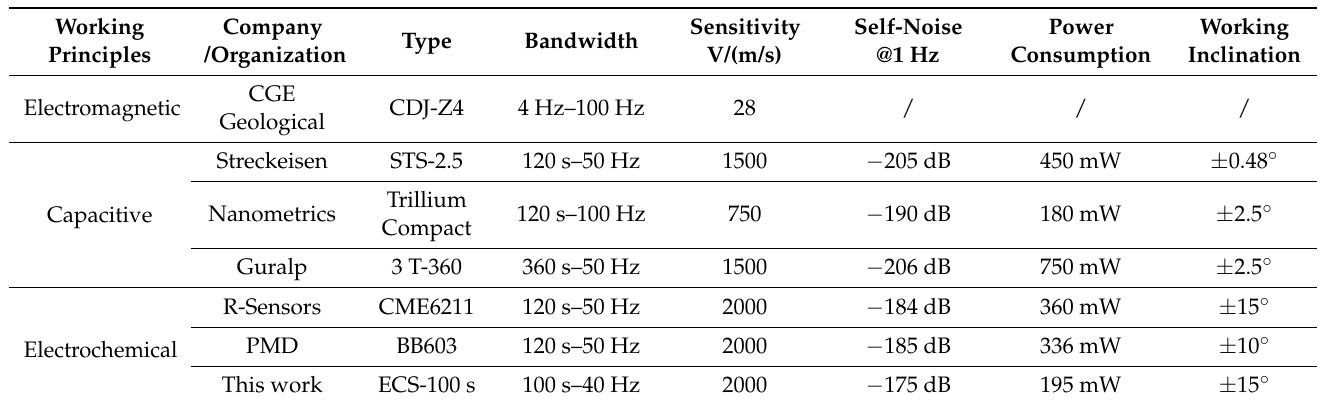
Table 1. Property comparisons of different types of seismic sensors